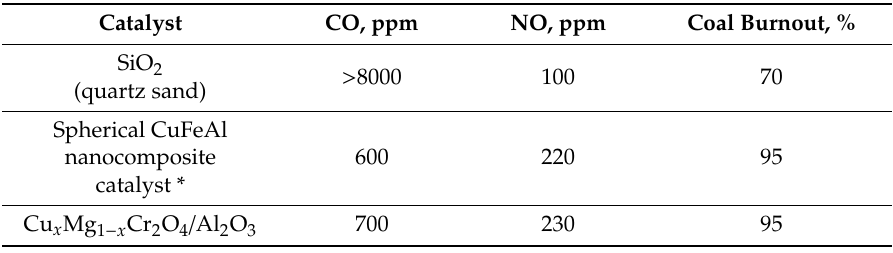
Table 5. Catalytic properties of the CuFeAl composite and Cr-containing catalysts.